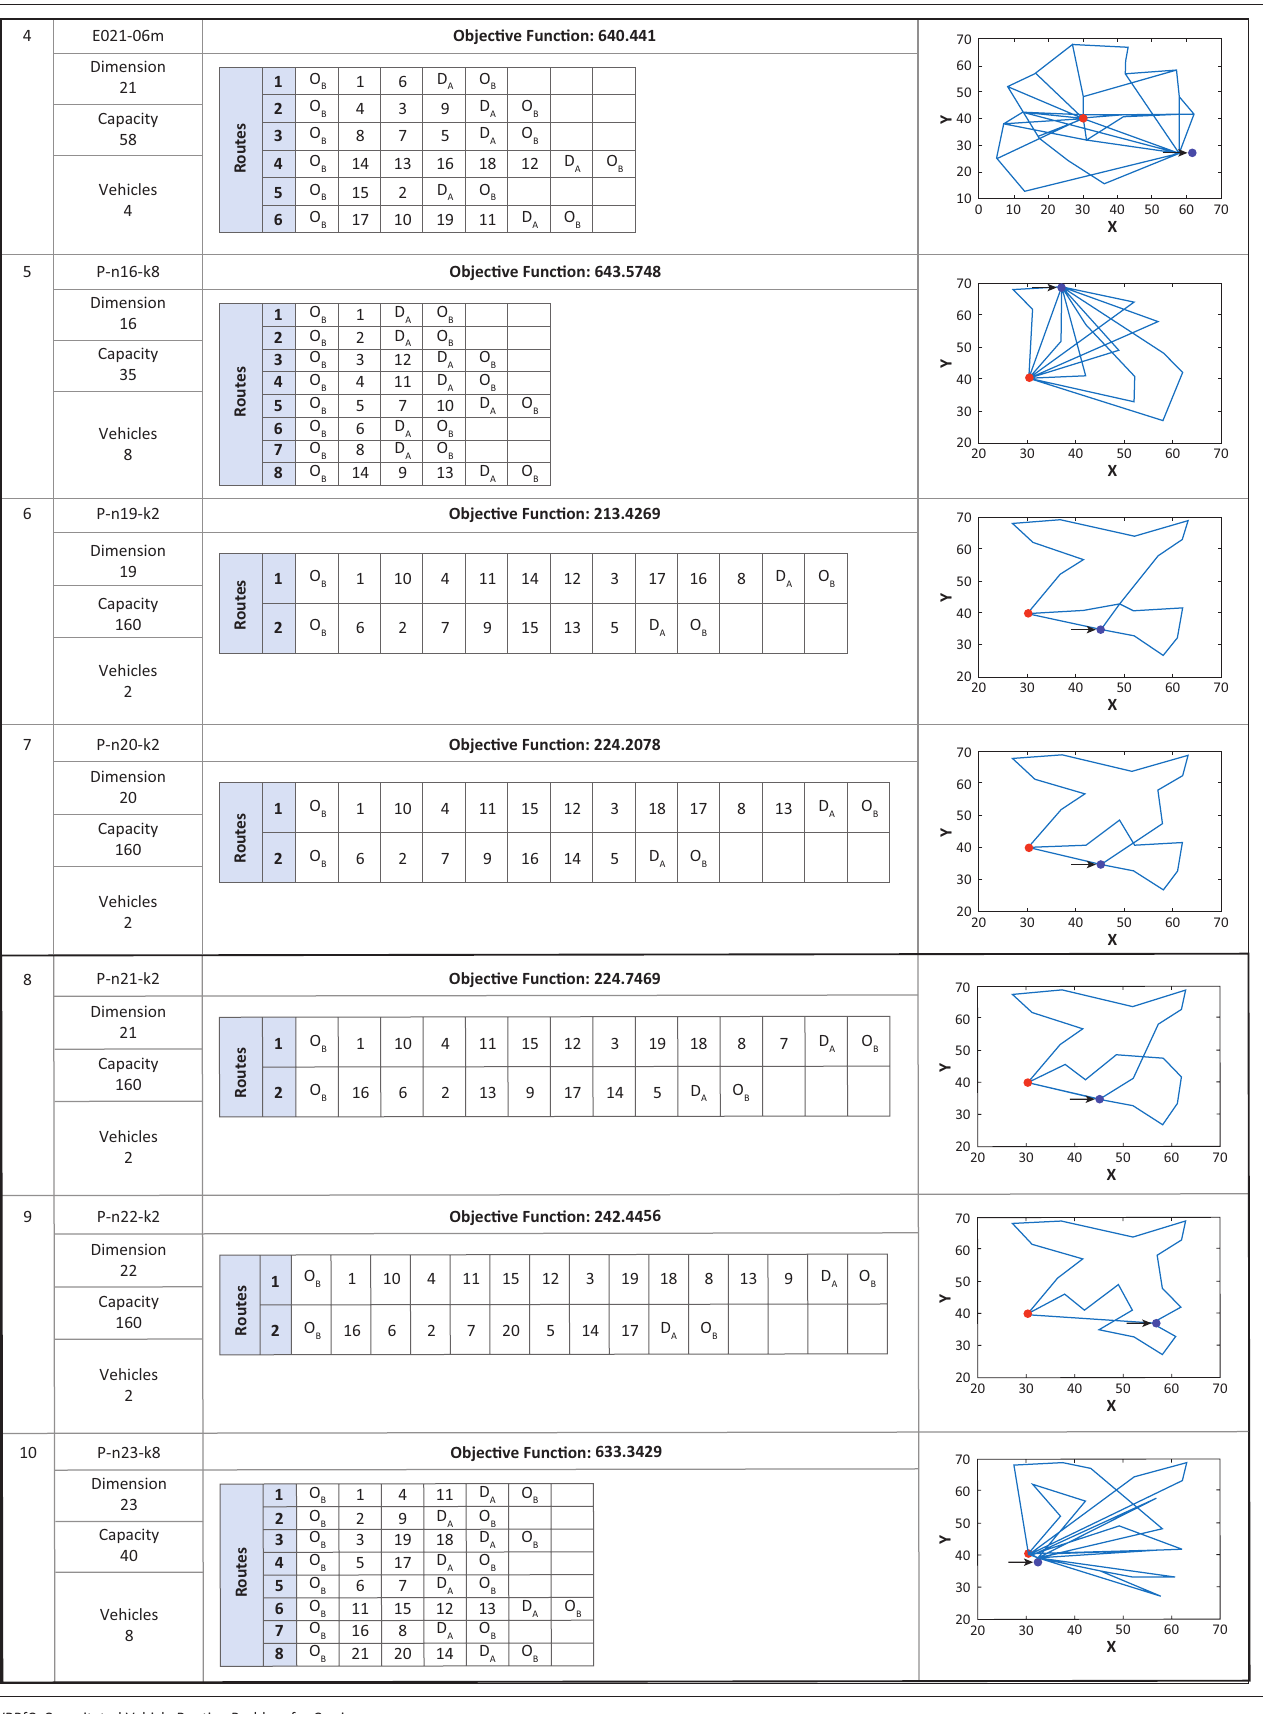
FIGURE 4 (Continues...): Solutions of the Capacitated Vehicle Routing Problem for Carriers model on adapted Vehicle Routing Problem LIBrary test